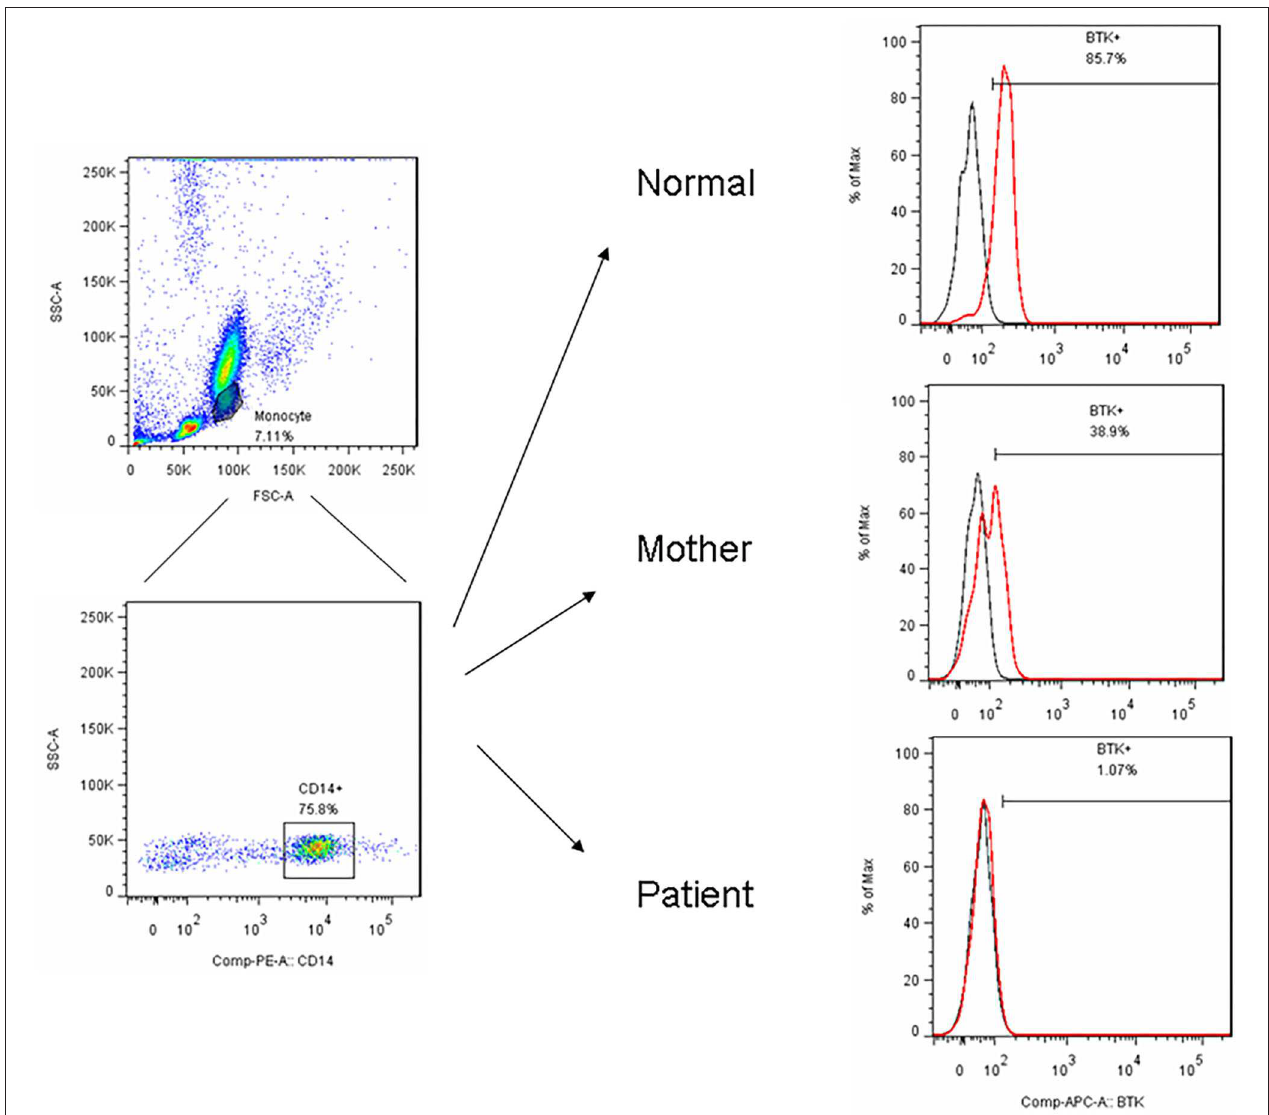
FIGURE 1 | After PBMC purified by centrifugation, we utilized FSC and SSC to locate the monocyte region and gated them by CD14 + in a representative patient (P15) with the BTK mutations showed an almost complete absence of BTK expression (1.1%) and a bimodal pattern in his carrier mother (38.9%) compared to the normal healthy control